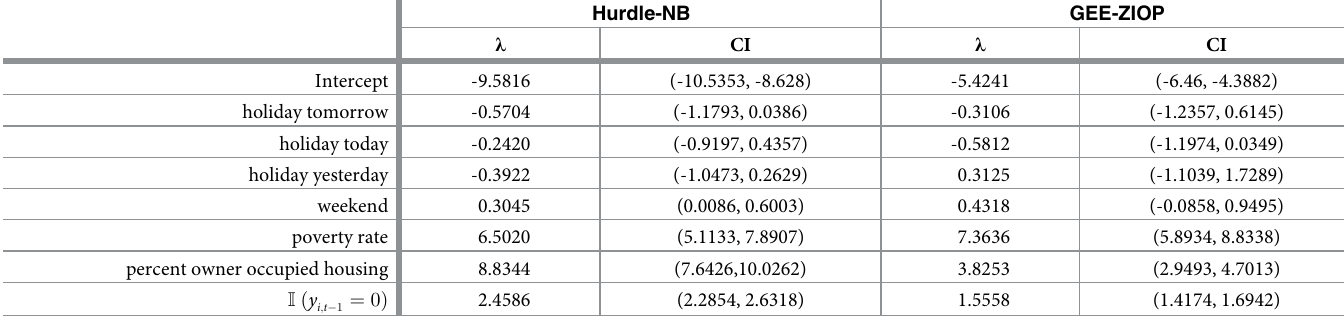
Table 6. Coefficients and 95% confidence intervals based on robust standard errors for the excess zero